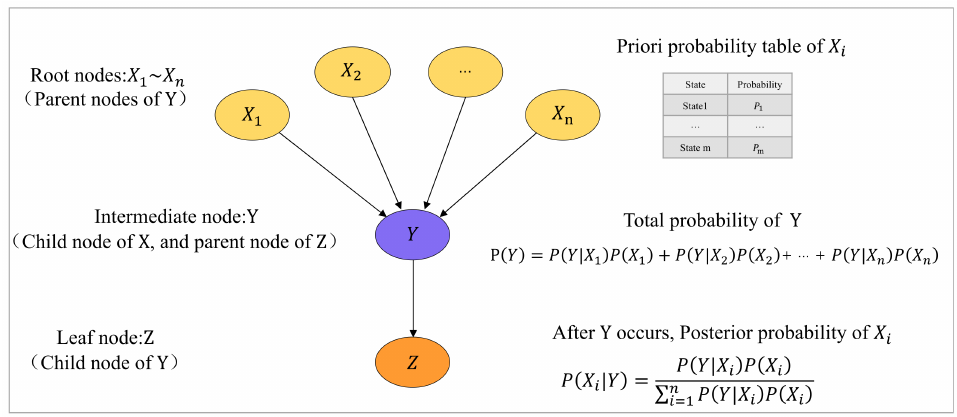
Figure 2. Basic structure of a